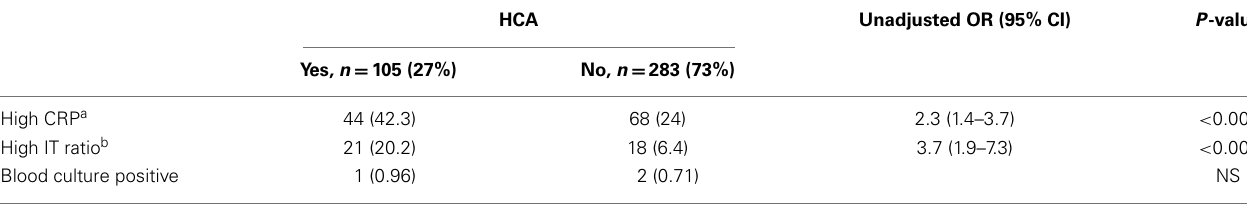
Table 1 | Sepsis work-up characteristics of infants with vs. without HCA.